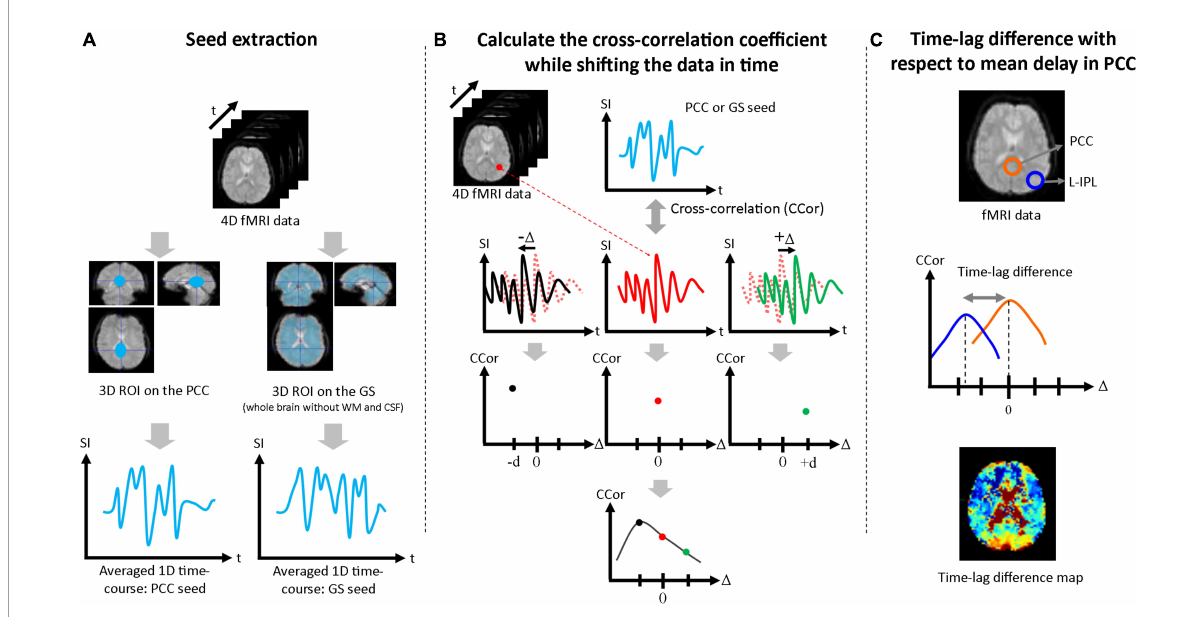
FIGURE1 Procedure used to assess time-lags between nodes of the DMN. (A) The PCC ROI and GS ROI (whole brain excluding WM and CSF) were extracted and averaged over to generate the 1D seed data. (B) The correlation coefficient between the 1D seed and the time-course at each pixel was calculated. Each single-pixel time-course was shifted in time ( (cid:49) ) and the correlation coefficient was calculated for each value of (cid:49) [i.e., CCor( (cid:49) )]. After cubic spline interpolation with respect to (cid:49) , the maximum value of the correlation coefficient was taken as the time-lag for that pixel. (C) Time-lag differences were calculated with respect to the mean time-lag in the PCC ROI and maps were produced to visually evaluate the time-lag across the brain. Mean time-lag differences were also calculated for the mPFC, L-IPL and R-IPL for further